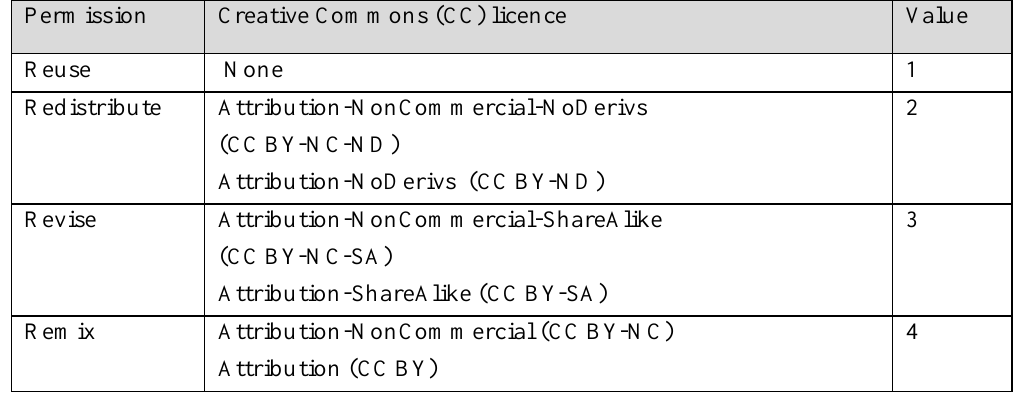
Openness Based on the CC License (Abeywardena, Raviraja, & Tham, 2012). Permission Creative Commons (CC) licence Reuse None Redistribute Attribution-NonCommercial-NoDerivs (CC BY-NC-ND) Revise Attribution-NonCommercial-ShareAlike (CC BY-NC-SA) Remix Attribution-NonCommercial (CC